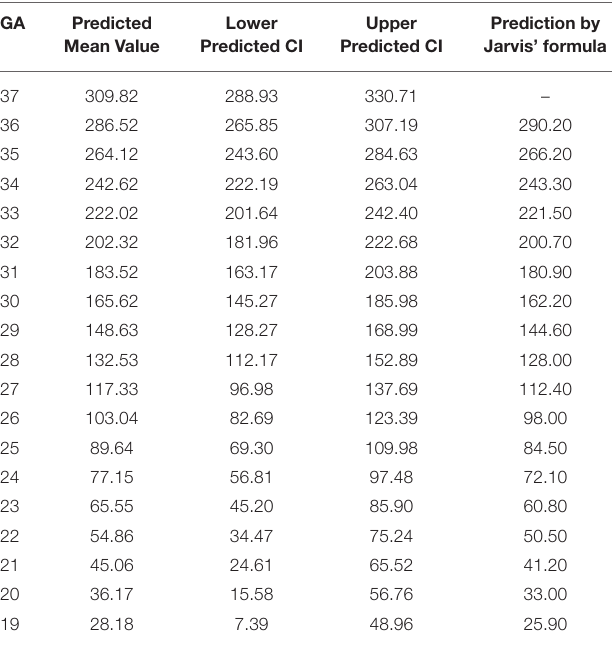
at 19 weeks and 294 ml at 36 weeks. When comparing the mean TABLE 3 | Total brain volume derived by our formula compared with predictive inference values calculated with formula by Jarvis et al. TBV with the expected values generated by the Jarvis’ formula for each GA week, our data were found to approximate GA Predicted Lower Upper Prediction by Mean Value Predicted CI Predicted CI Jarvis’ formula